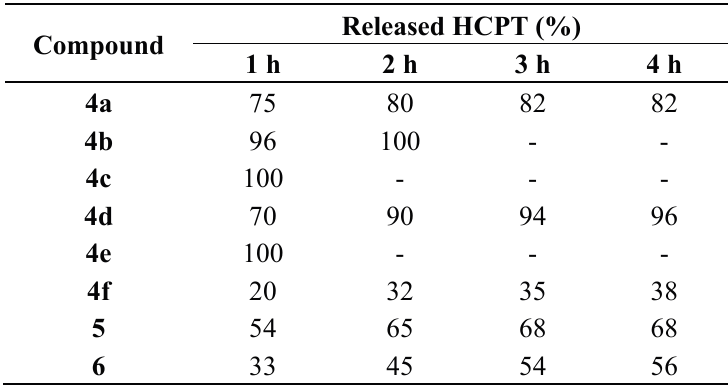
Table 2. Stability of the conjugates at pH